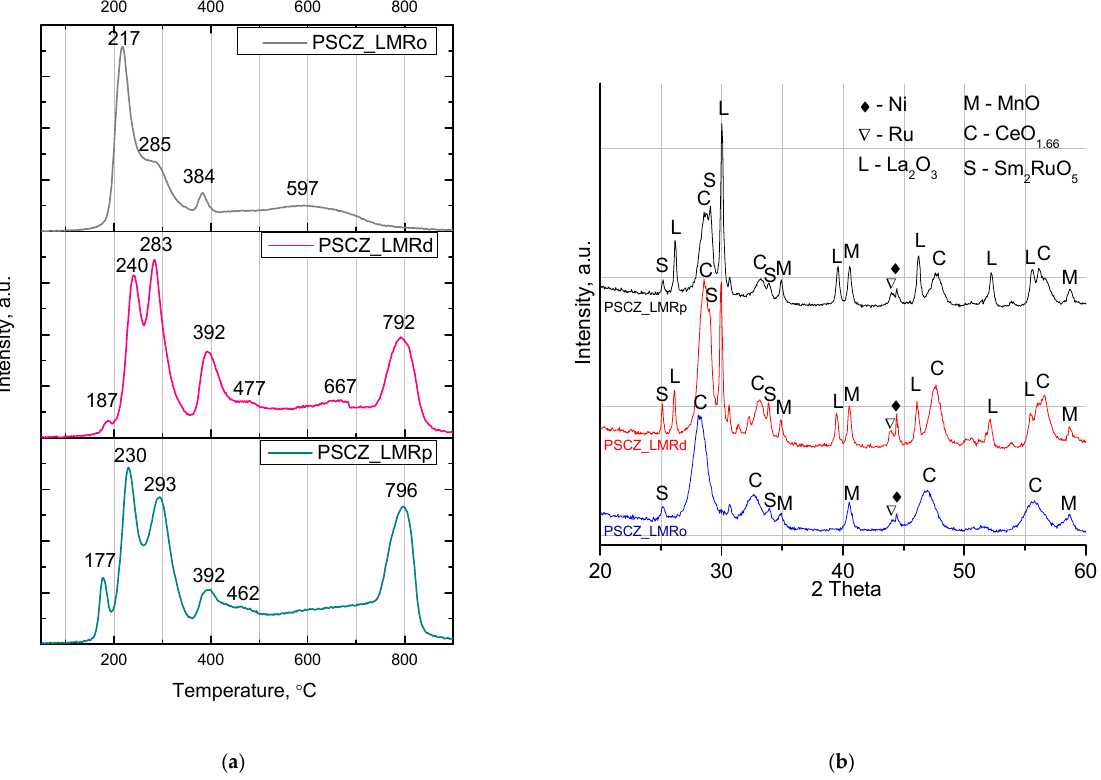
Figure 2. ( a ) The H 2 -TPR profiles of NiPSCZ_LMR samples; ( b ) The XRD patterns of the samples reduced in H 2 at 800 °C.